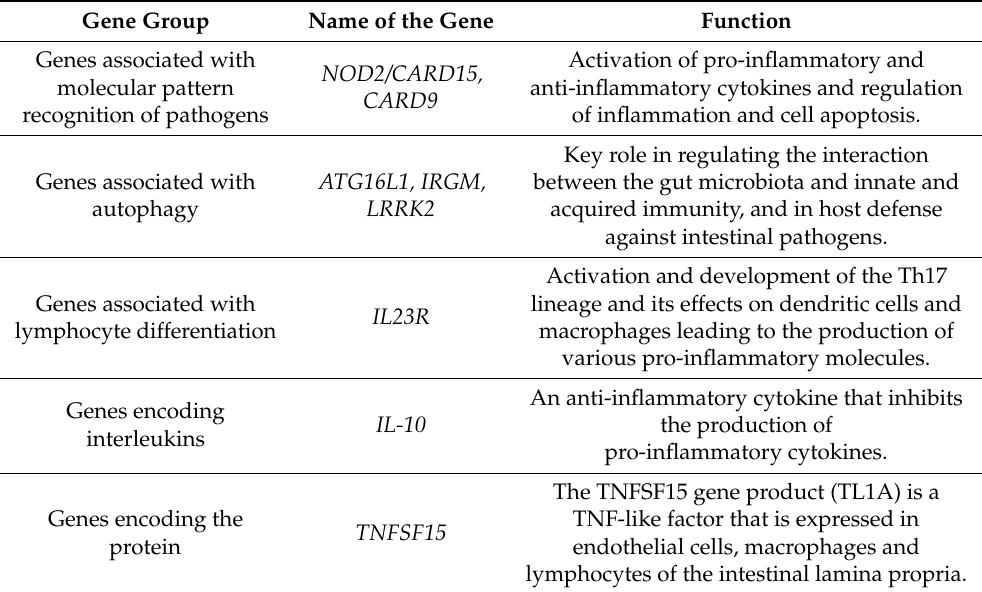
Table 4. Summary of genes described versus immune system in